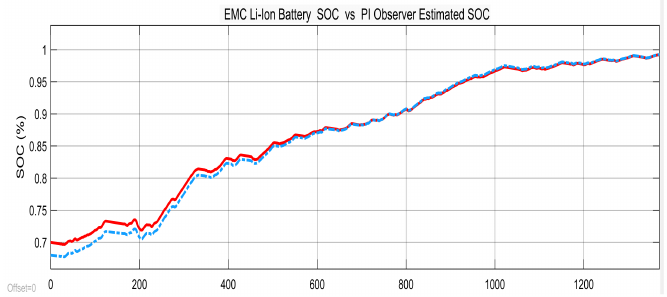
Figure 32. The 2RC EMC Li-Ion Battery SOC versus PIO SOC real-time estimator.